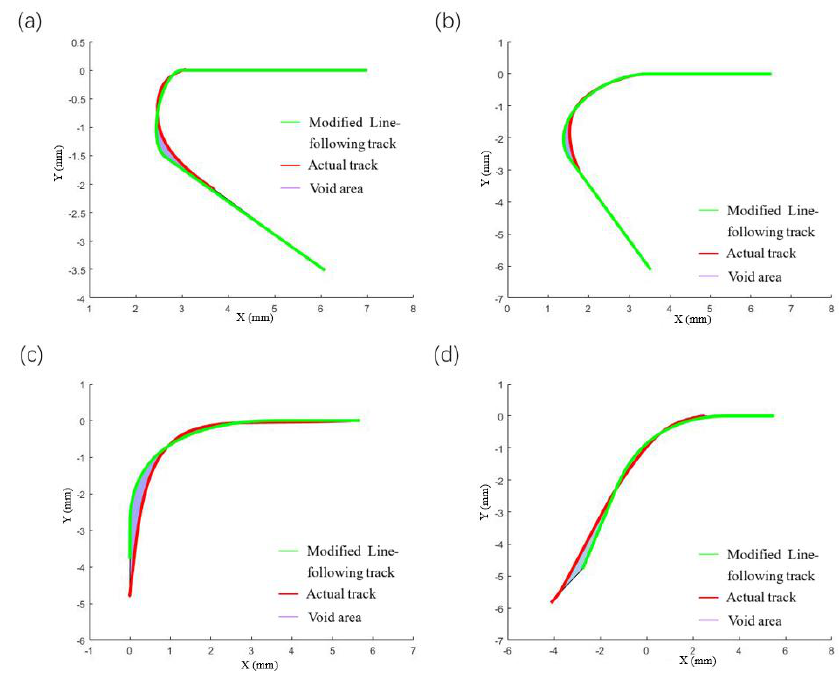
Figure 21. Test of the smallest area of bridge after removing the smallest curvature at different corner angles, ( a ) 30°, ( b ) 60°, ( c ) 90°, ( d ) 120°.